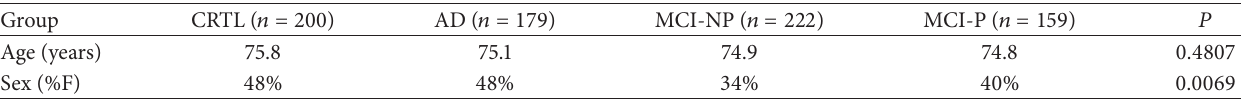
Table 1: Demographics.